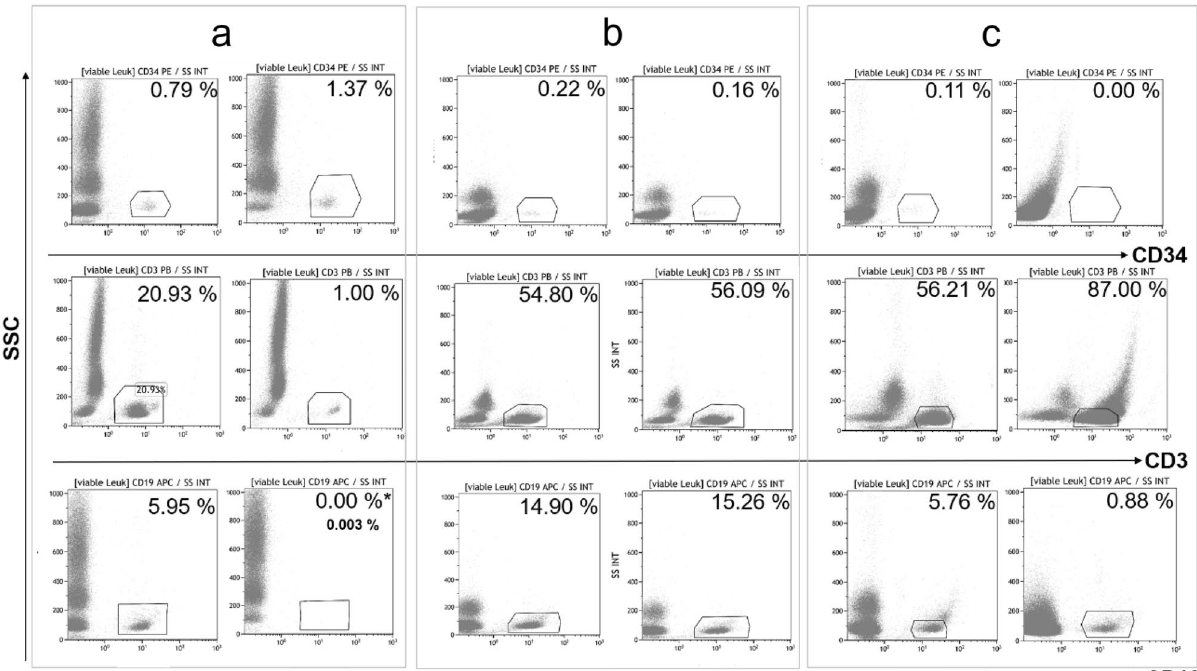
Figure 3. Application examples (each n = 1 before and after the manufacturing step) for the pre-formulated dried reagent panel with CD45 FITC, CD34 PE, 7-AAD, CD3 PB, CD19 APC and counting beads after method validation of standard stem cell products and donor lymphocytes. The samples were analyzed each as double approach. ( a ) CD19-TCR α/β-depletion: A mobilized stem cell apheresis of a heathy donor was incubated with magnetically antibodies against CD19 and TCR α/β-antigens from Miltenyi Biotec and depleted with the CliniMACS System. The assay was tested with cells before (part a , left) and after CD19-TCR α/β depletion